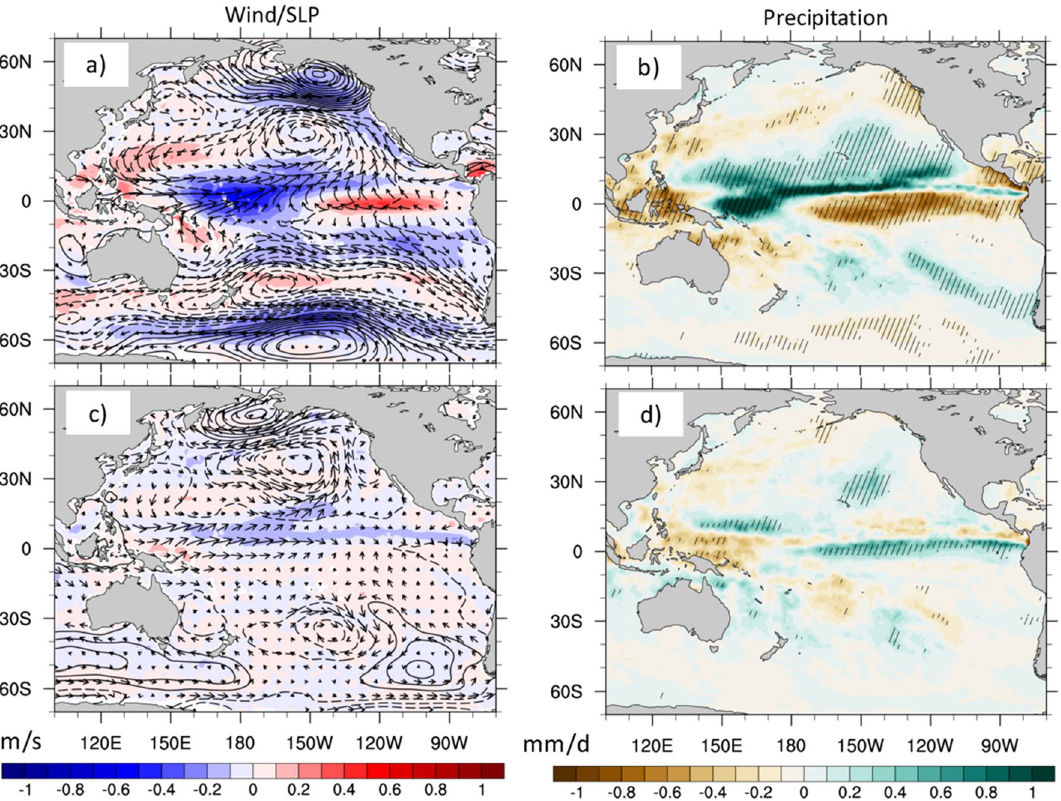
Figure 5. Atmospheric fields associated with the sensitivity patterns. ( a ) Linear regression of wind speed (shading, m/s), SLP (black contours, negative values dashed, Pa), and vector winds (arrows, m/s) on the index associated with the SST/SSH sensitivity pattern for CP events. ( b ) Linear regression of precipitation on the sensitivity pattern index for CP events. Hatched regions are statistically significant at the 95% level. ( c ) and ( d ). Same as ( a ) and ( b ), but for EP events. Wind speed data are from satellites, while SLP, vector winds and precipitation are from